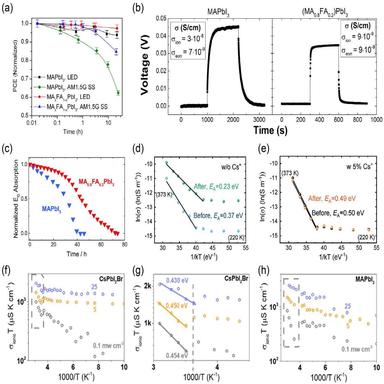
(a) Photo-stability of MAPbI3 and MAxFA1xPbI3 PSCs under different illumination conditions. Copyright 2015, American Chemical Society. (b) Ionic and electronic conductivity of MAPbI3 and MA0.8FA0.2PbI3. (c) Changes of ultraviolet–visible (UV–Vis) absorption for MAPbI3 and MA0.8FA0.2PbI3 films under different illumination time . Copyright 2018, Royal Society of Chemistry. Temperature-dependent conductivity of MAPbI3 (d) and MA0.95Cs0.05PbI3 films (e) before and after 1 h of oxygen and photo in